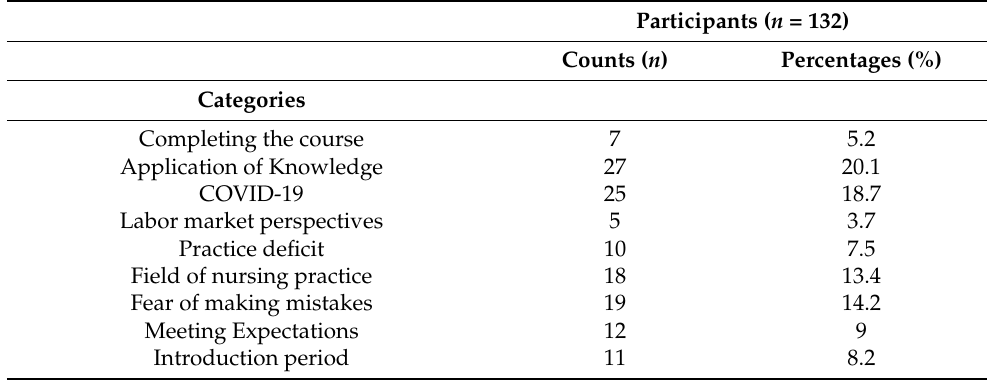
Table 2. Concerns during the COVID-19